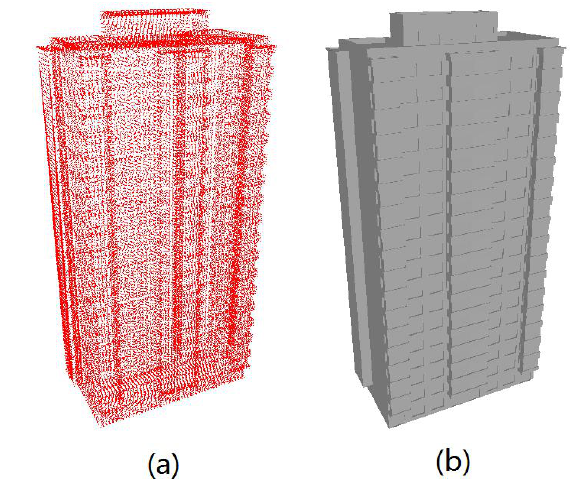
Figure 1. Geometric building model construction. (a) The registered point clouds of the building model. (b) The constructed 3D surface building model.